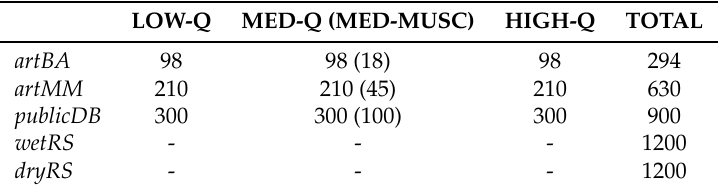
Table 1. Composition of each database in terms of number of LOW-Q, MED-Q, MED-MUSC, HIGH-Q labelled EEG segments.